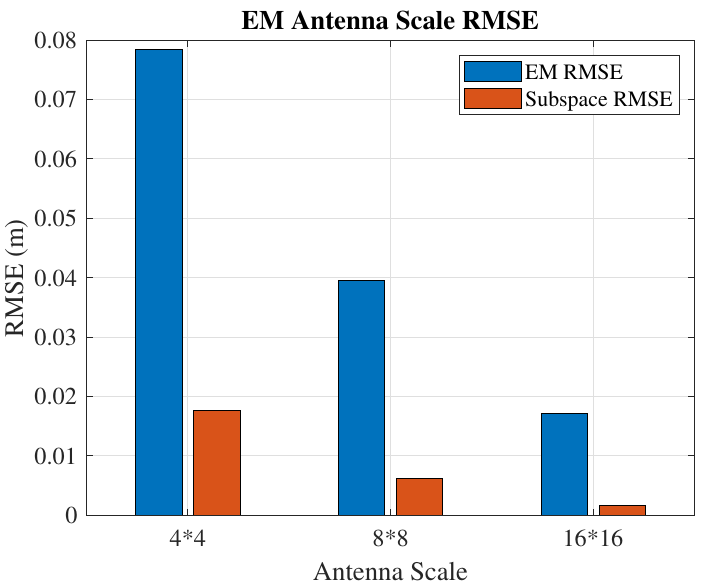
Figure 6. Positioning accuracy of the EM and subspace algorithms with known distance and esti- mated